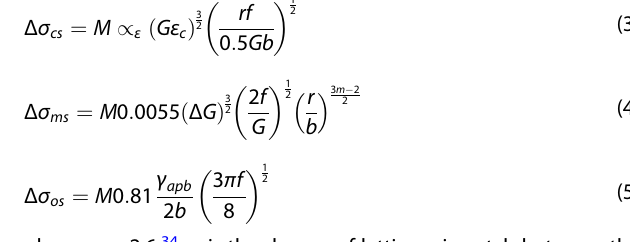
ffiffiffiffiffiffiffiffiffi p 2 = 3 r